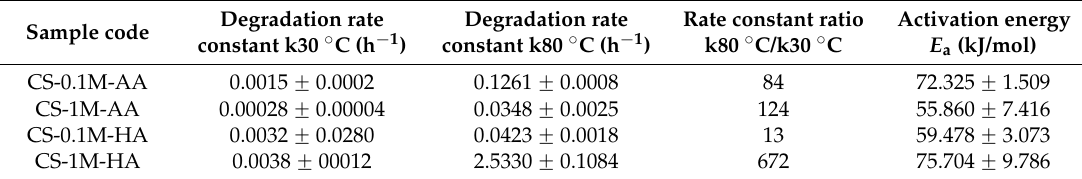
Table 3. Degradation rate at 30 and 80 °C, Degradation rate ratio, and activation energy of solution compositions.